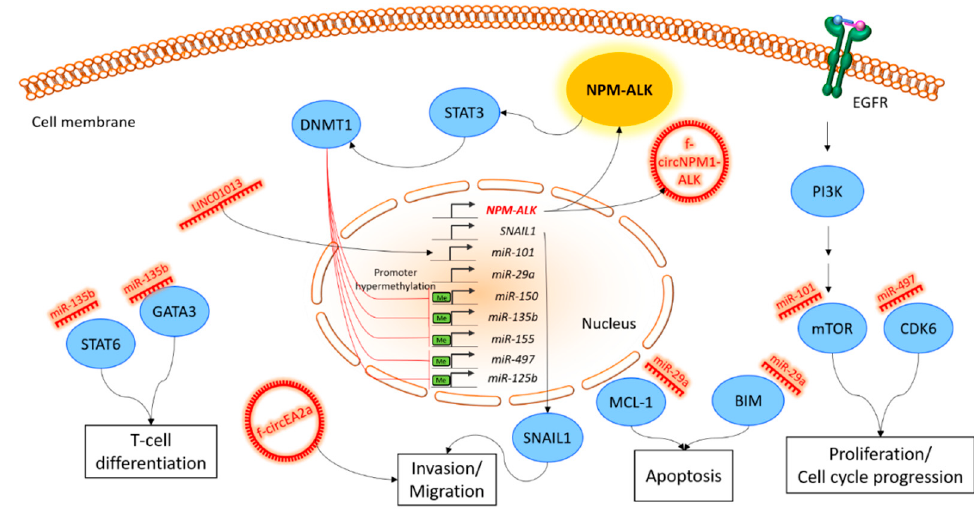
Figure 1. Schematic overview of non-coding RNA involvement in key cellular pathways of ALK-positive ALCL. The figure shows representative examples of the discussed ncRNAs, together with their influenced signaling pathways or the cellular function in ALCL. The expression of the NPM-ALK fusion protein as a central molecular hallmark of ALK-positive ALCL influences various pathways, including STAT3. STAT3 activates DNMT1 and subsequently methylates several miRNA promoters. The deregulation of miRNA expression strongly influences crucial signaling cascades, like PI3K / AKT / mTOR, as well as cellular hallmark processes such as proliferation, invasion and T-cell di ff erentiation. The ceRNA activity of other non-coding RNA entities, such as circRNAs, which can arise from gene fusion events, such as NPM - ALK , and the activity of lncRNAs, are dependent on a defined pool of miRNAs and are thereby regulated by the NPM-ALK activity. STAT3, signal transducer and activator of transcription 3; DNMT1, DNA (cytosine-5)-methyltransferase 1; GATA3, GATA binding protein 3; STAT6, signal transducer and activator of transcription 6; SNAIL1, snail